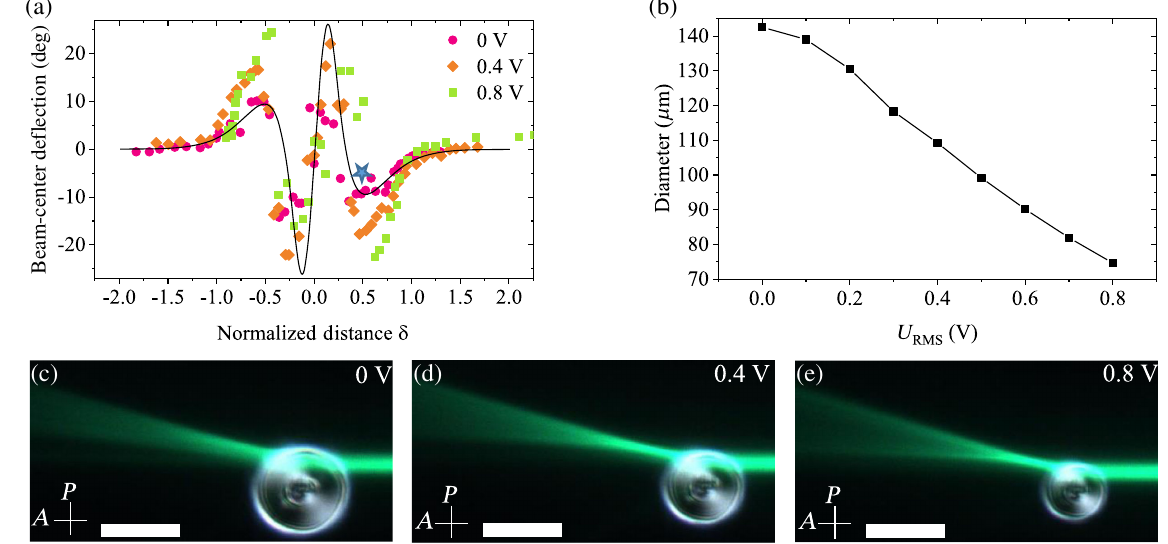
FIG. 10. Modulation of beam-center deflection by the application of an electric field along the far-field uniform director n 0 , which is orthogonal to the beam-propagation plane. (a) Incident extraordinary-mode ( e -mode) beam-center deflection plotted against the normalized distance δ . Three datasets are collected for three different electric potentials as indicated. The solid curve is the behavior predicted by our simple ray-tracing model. For the beam-center deflection peaks at δ ¼ (cid:4) 0 . 5 , larger beam-center deflection is attributable to an asymmetric broadening and lensing of the beamwidth for different toron diameters, which map to applied potentials as indicated in (b). (b) Measured toron diameter plotted as a function of the electric potential for the experimental system. (c) – (e) Incident e -mode light deflected by three instances of a toron experiencing different electric potentials. The normalized distance of interaction δ ¼ 0 . 5 is constant as indicated by the star in (a). The shift in beam-center deflection is attributable to the contracting toron ’ s distortion profile despite a constant incident beamwidth. Negative angles in (a) correspond to the clockwise deflection of the beam in (c) – (e), as defined in Fig. 9(a). The scale bar ’ s length represents 100 μ